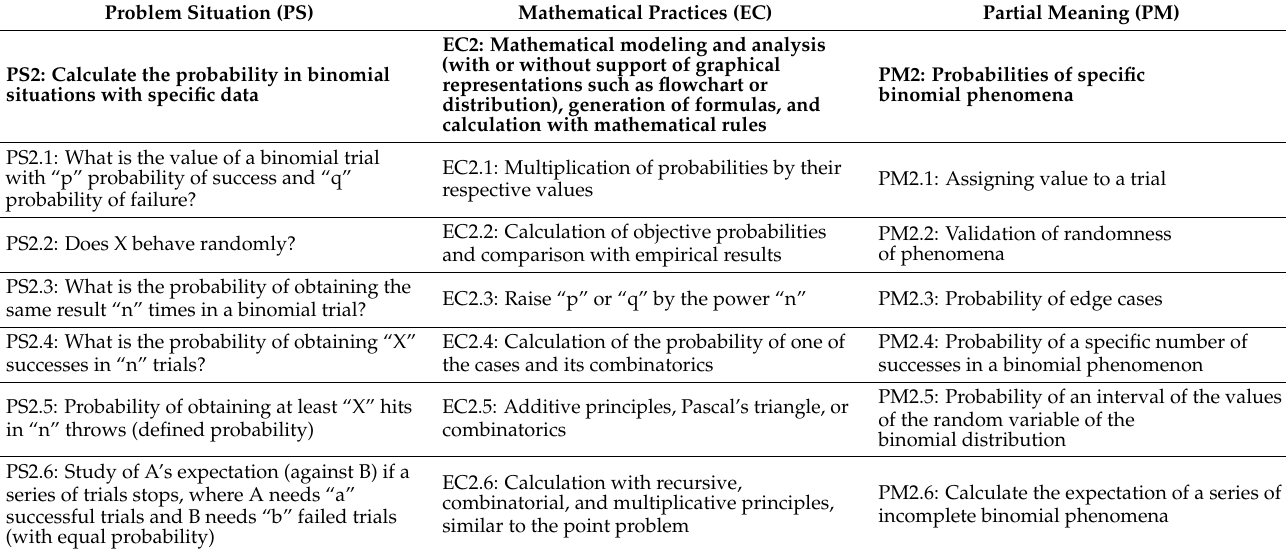
Table 5. Practice system for binomial situations with one variable or for specific